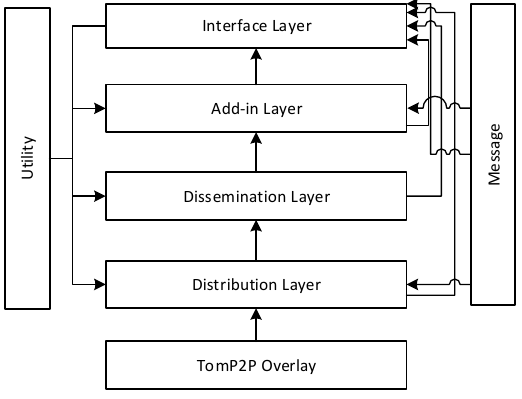
Figure 1. MediaSense